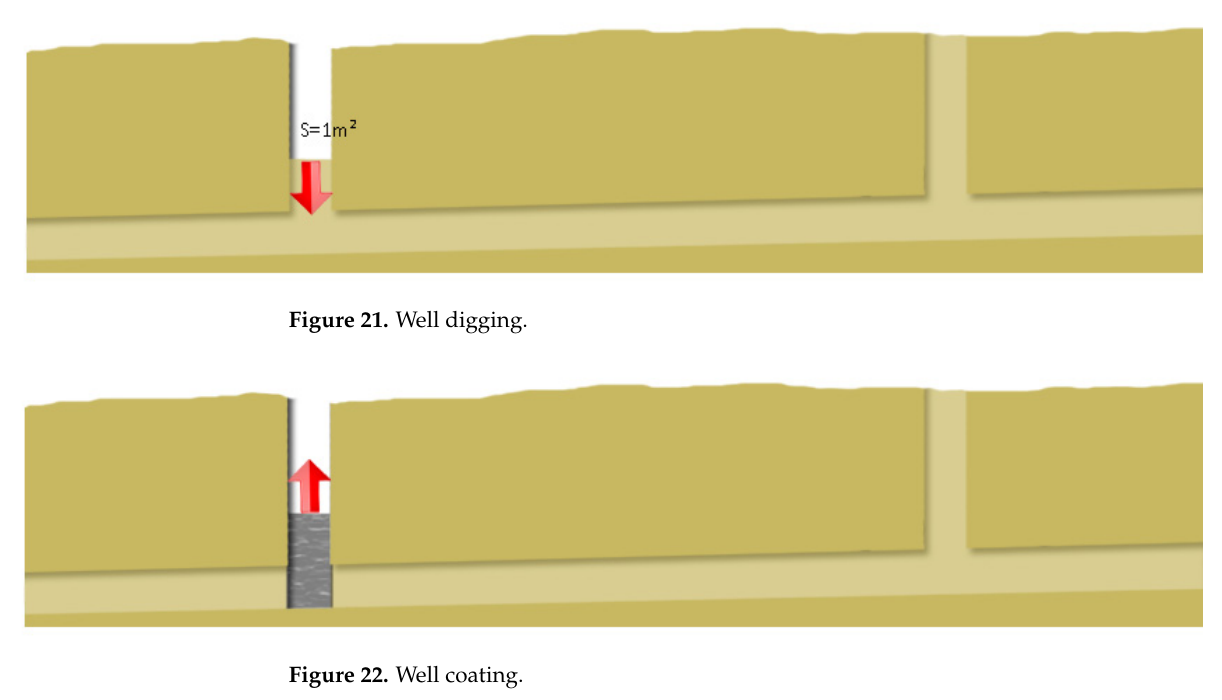
Figure 23. Tunnel digging. Figure 24. Tunnel coating.